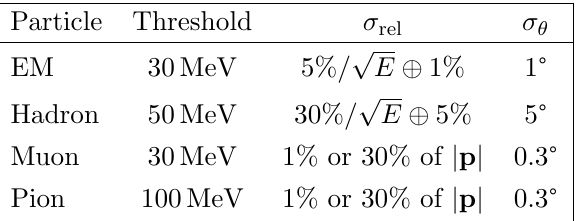
Table 5 . The table lists detection thresholds and energy/momentum and angular resolutions used in the fast MC, where \EM" delineates electro-magnetic showers and \Hadron" any other charged particle which is neither a lepton nor a pion. The momenta of pions and muons are smeared according to the containment of their tracks. If the particles enter the MPD in which they cover a length longer than the detector’s diameter or if 80 % of the tracks are contained inside the LArTPC then the relative resolution on the momentum is 5 %, otherwise a resolution of 30 % is